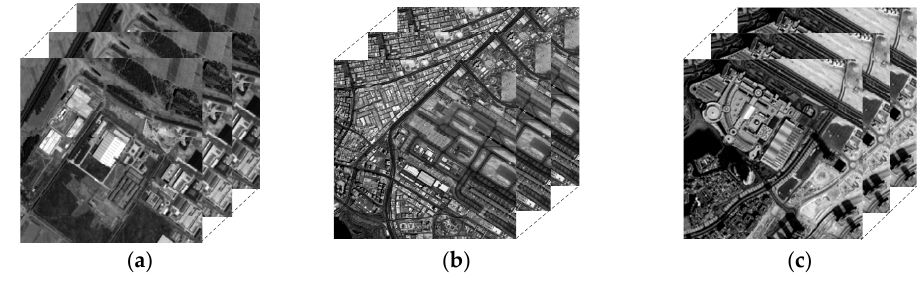
Figure 3. Simulated remote-sensing image data.